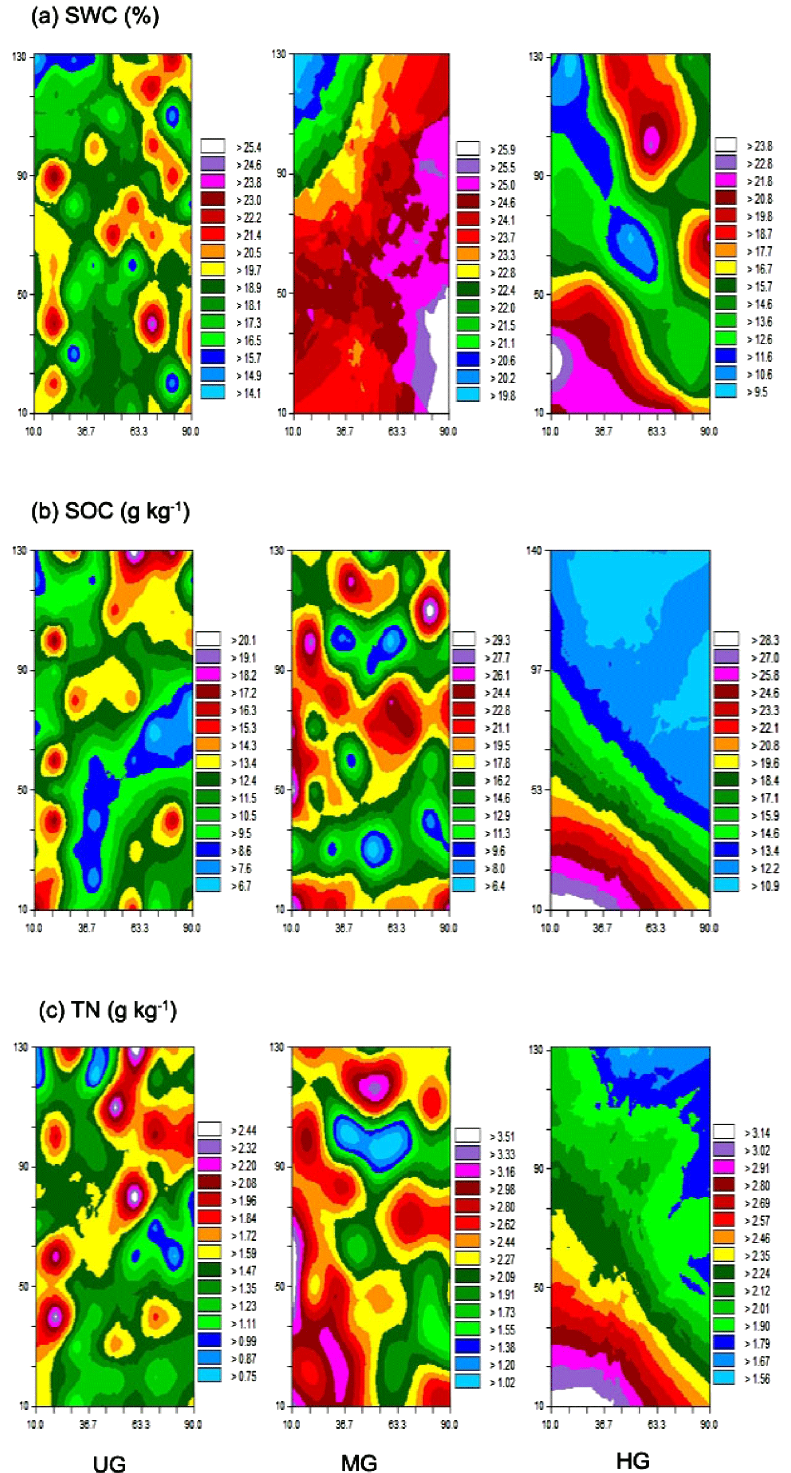
Figure 7. Spatial distribution of (a) soil water content (SWC), (b) soil organic carbon (SOC) and (c) soil total nitrogen (TN) under three different grazing intensities: ungrazed (UG, first column), moderate grazing (MG, second column) and heavy grazing (HG, third column).